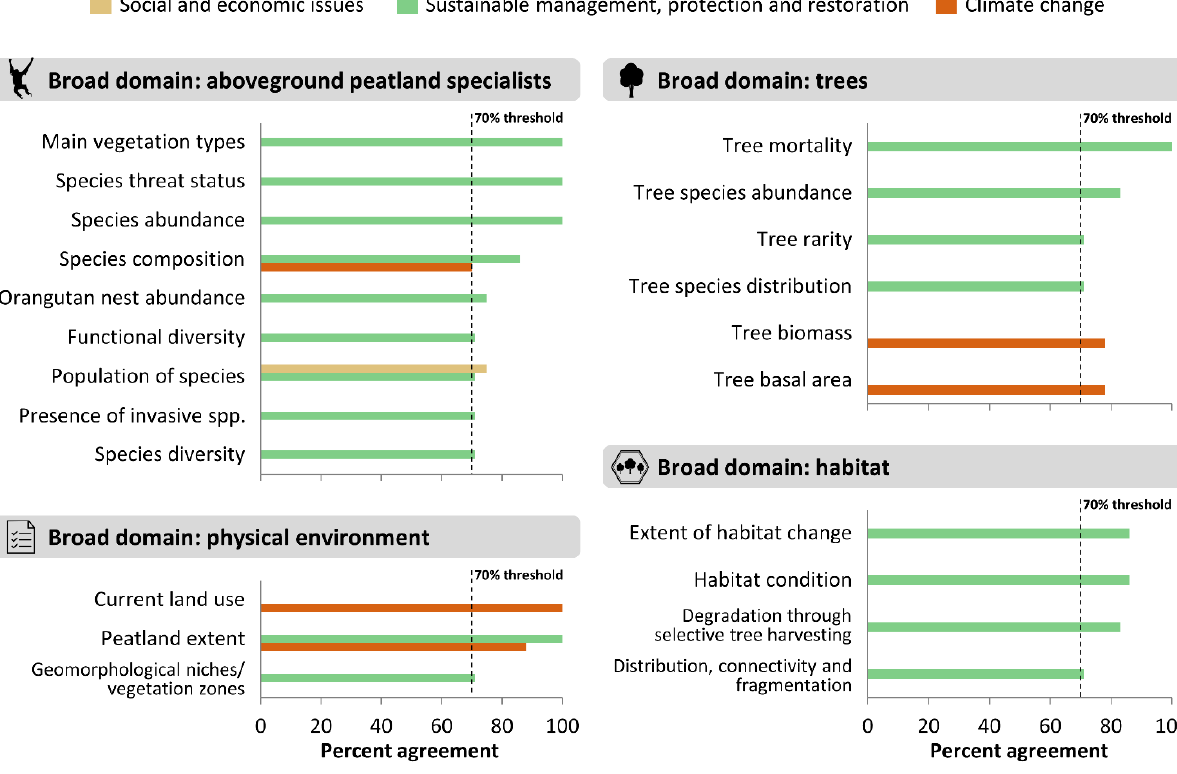
Figure 9. Biodiversity core domain set, and the constituent target domain outcomes agreed by ≥ 70 % of respondents as potential high priorities for measurement in tropical peat swamp research or monitoring, depending on the objective or focus of the research or restoration project (based on 12 expert responses). Scores < 70 % are not